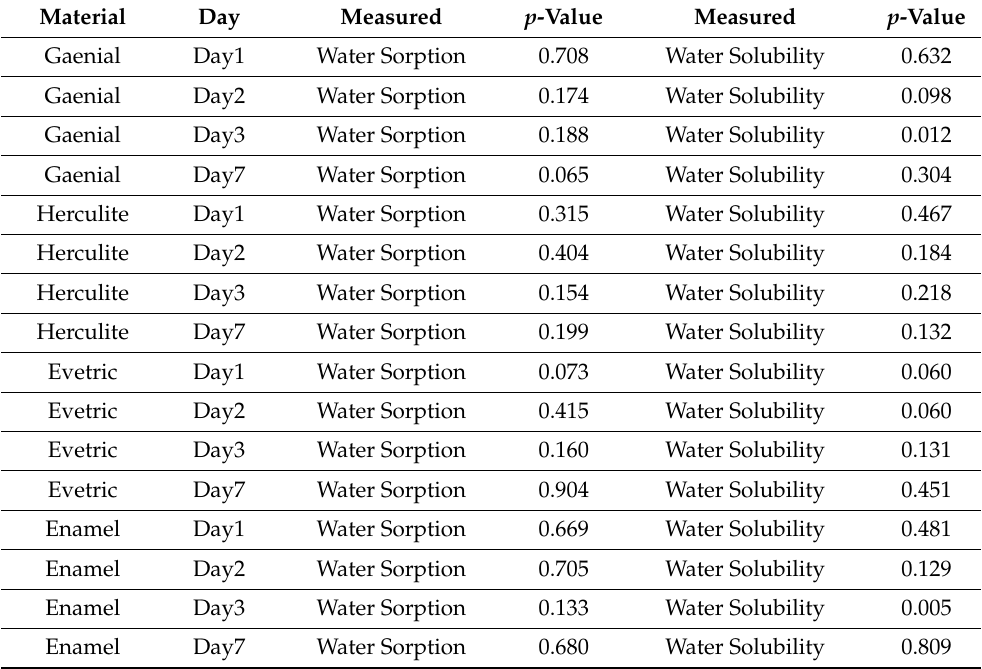
Table 2. Differences between the experimental conditions within each day, material used and measurement